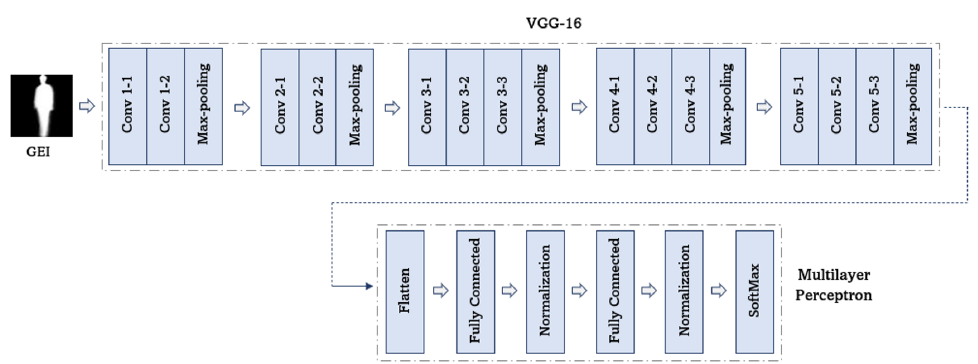
Figure 1. Sample GEIs obtained from different datasets, CASIA-B ( first row ), OU-ISIR D ( second row ), and OU-LP ( third row ).